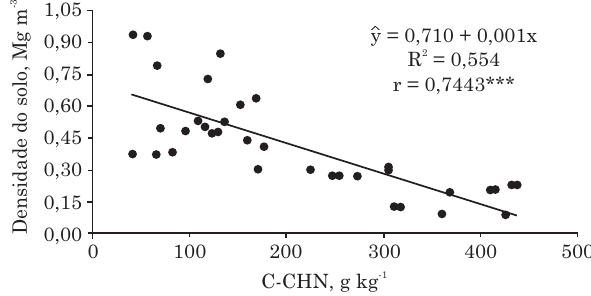
Figura 1. Diagrama de dispersão e regressão da densidade do solo em função do teor de carbono (C determinado pelo método de combustão a seco em analisador elementar CHN). Fonte: Ebeling et al. (2011).